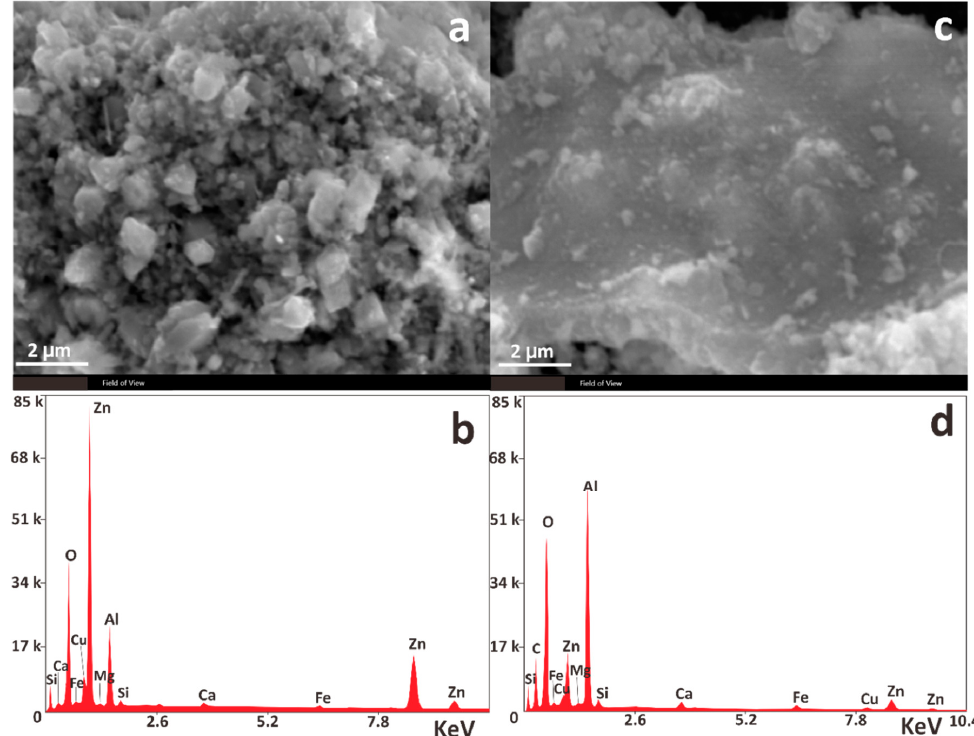
Figure 3. Morphology ( a ) before and ( b ) after leaching, including EDS intensities of elements based on mapping on the respective field ( c ) before and ( d ) after leaching. mapping on the respective field ( c ) before and ( d ) after